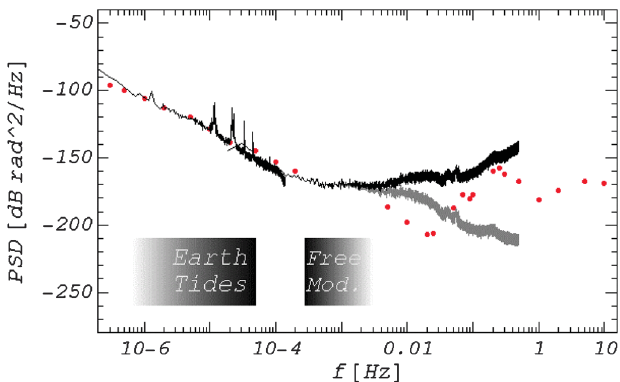
FIG. 30. (Color) The PSD of the 6-years-long record in Walferdange (with and without the instrumental response cor- rection—black and gray curve, respectively) and the low tilt noise reference model from Ref. [9] (red dots). Shaded rectan- gles pinpoint the frequencies ranges of the Earth tides and the Earth free modes (from Ref.